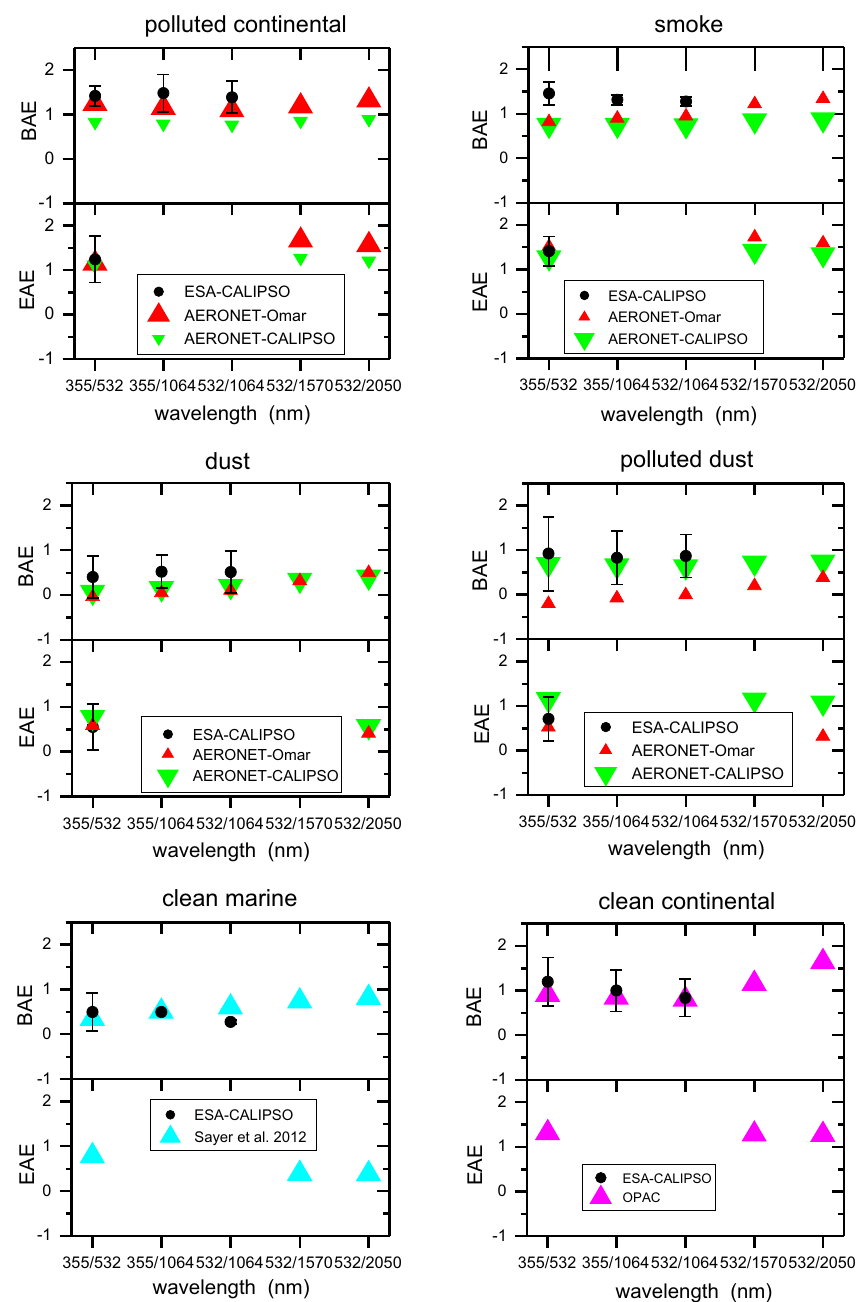
Figure 2. BAEs (upper) and EAEs (bottom) calculated with different approaches (i.e., AERONET-Omar (red triangles), AERONET- CALIPSO (green triangles), Sayer et al. (2012) (cyan triangles), OPAC (pink triangles)) and validated against the ESA-CALIPSO BAEs and EAEs in VIS and UV spectral ranges (black circles). The BAEs and EAEs selected and ingested in the LIVAS aerosol model for the VIS–IR conversions, are denoted with symbols of larger